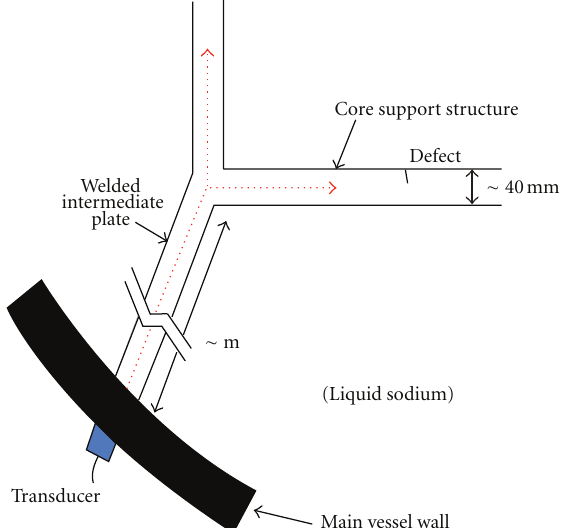
Figure 12: Inspection of structures used as wave